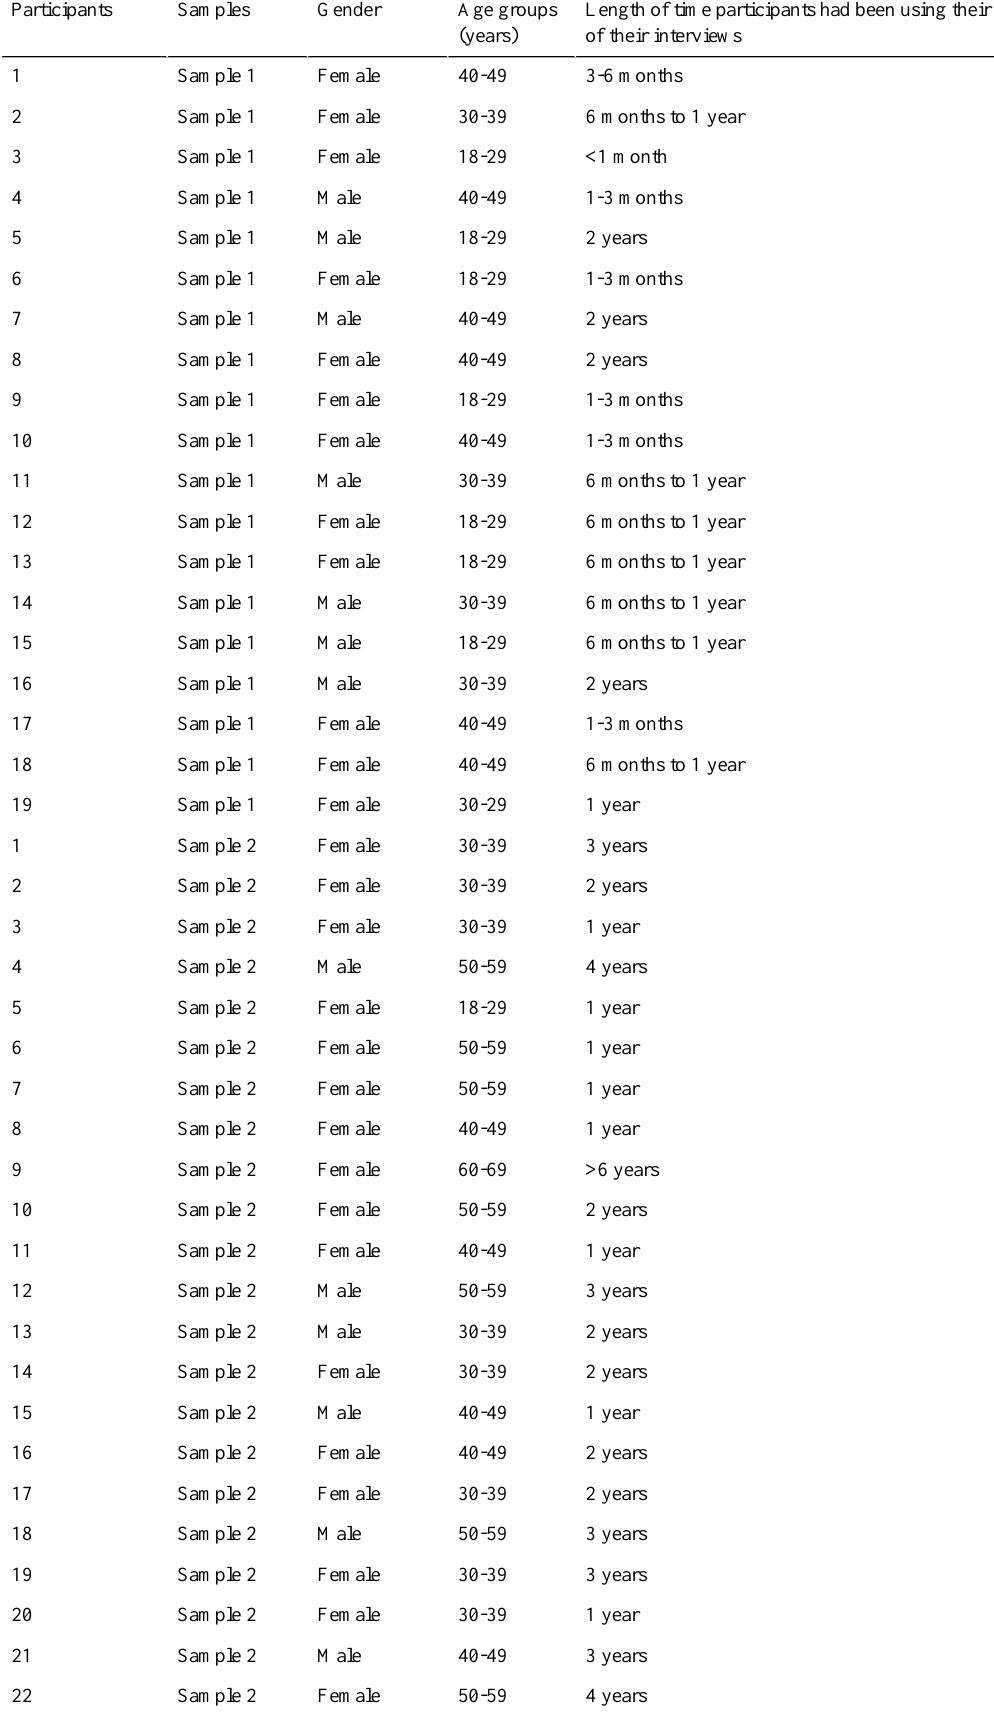
Length of time participants had been using their digital health technology at